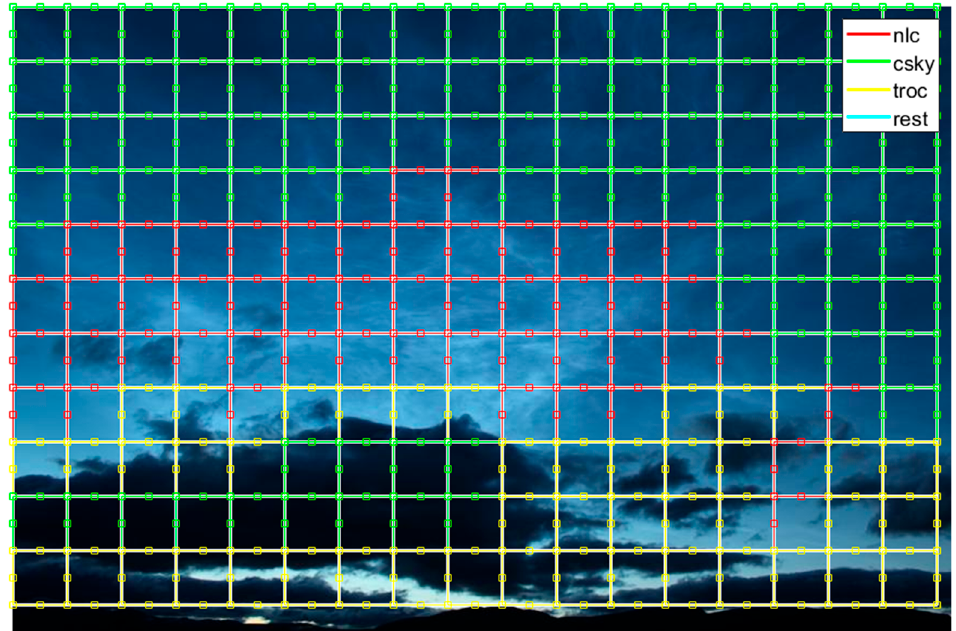
Figure 15. An example of false-positive detections by the CNN algorithm. 5. Discussion In order to investigate if noctilucent clouds can be identified from tropospheric clouds, clear sky, and rest of the objects, first, we employed LDA. For LDA, feature vectors with simple features such as: mean, standard deviation, max and min, and more complex feature vectors such as: HLAC and HOG were used. The results from LDA show that first, LDA using mean, standard deviation, max and min values as feature vectors performs better than LDA approaches using mean only, LDA using mean and standard deviation, and LDA using HLAC. Second, LDA using HOG as feature vectors outperforms all other LDA based approaches. This implies that HOG descriptor is relatively good at capturing the features associated with noctilucent clouds that enable their discrimination from other